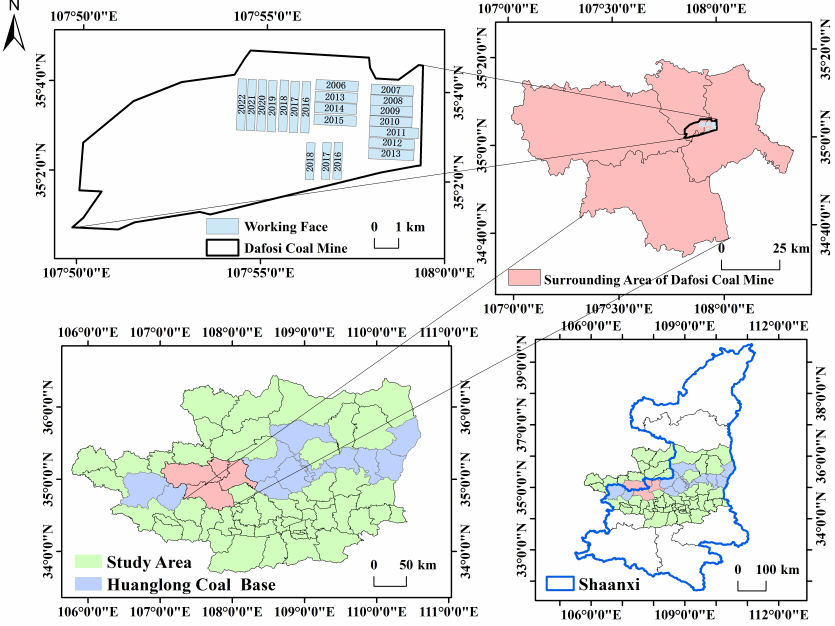
Figure 9. Location of Dafosi coal mine in China Loess Plateau (CLP) and Shaanxi